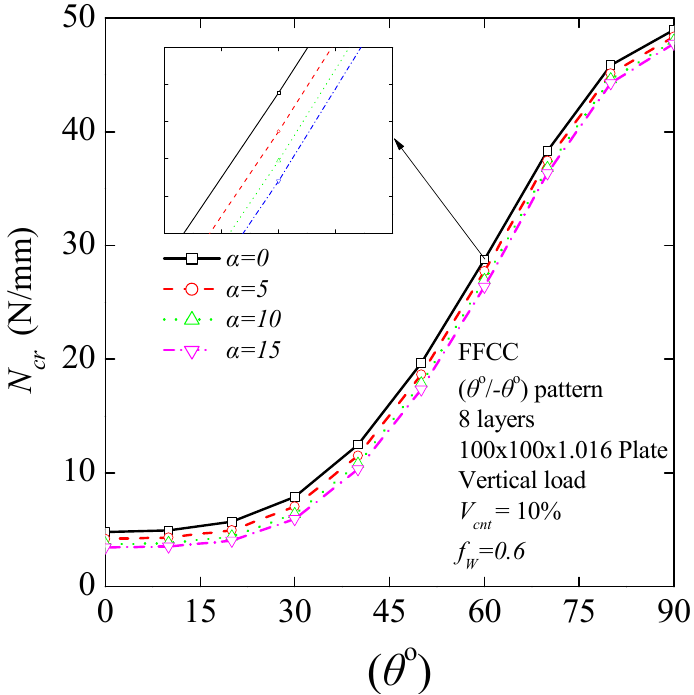
Figure 10. Critical buckling load as a function of fiber orientation angle for V cnt = 10% and various agglomeration factors, f A .